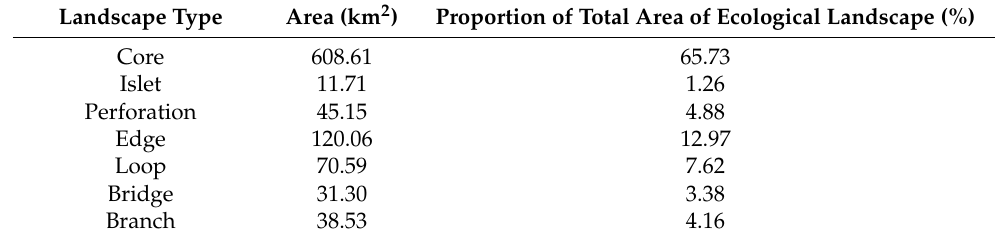
Table 5. Landscape types in Guanling County.